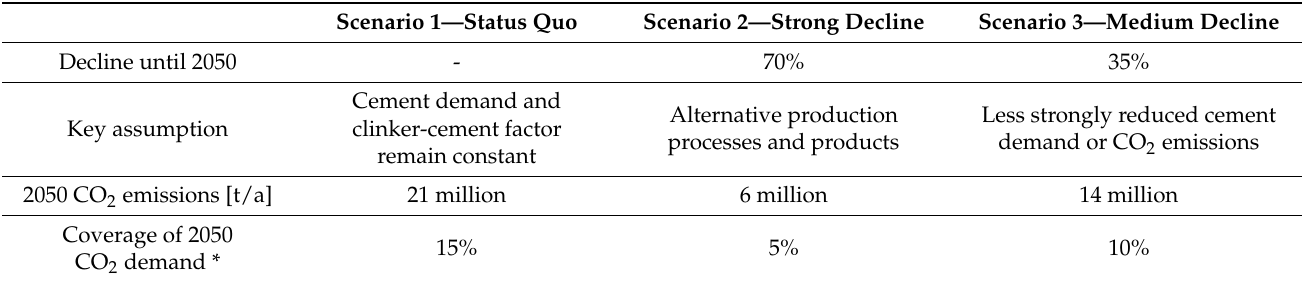
Table 1. Scenario